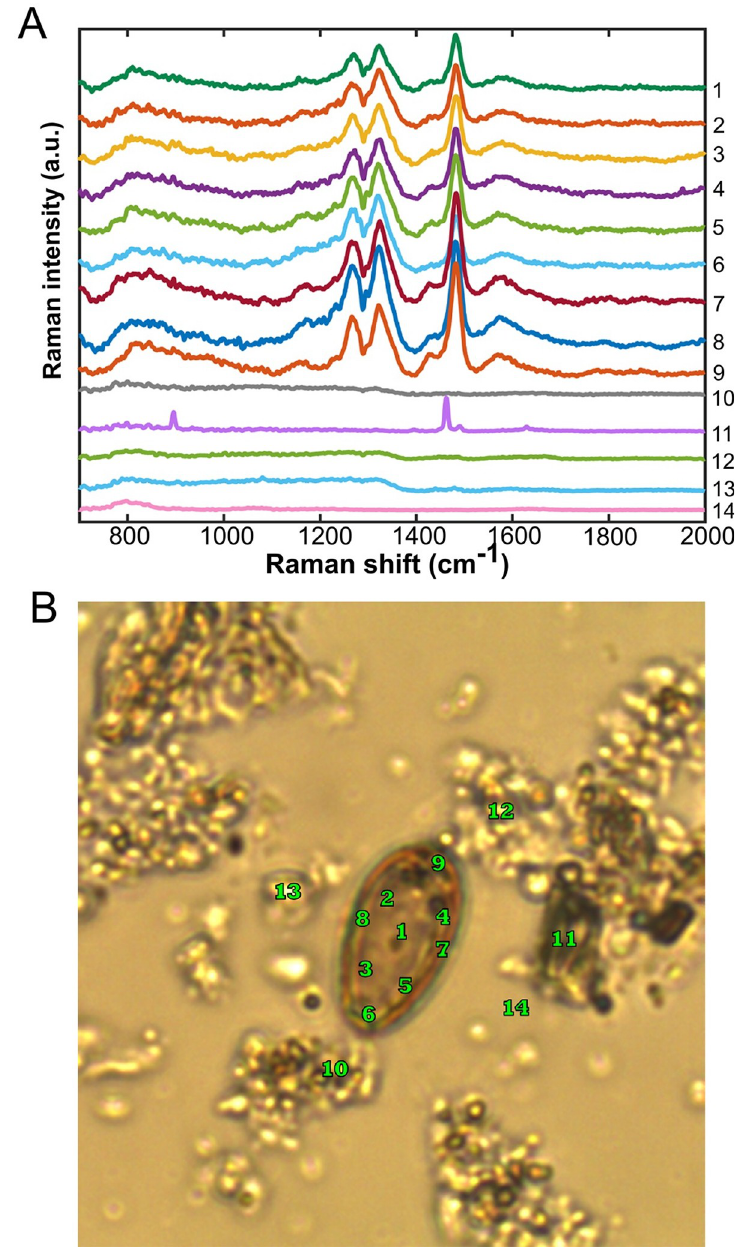
Fig 5. Lateral Raman scanning of an individual O . viverrini egg. (A) Raman spectra were taken at different spots, as shown in (B), within an O . viverrini egg vs. outside the egg boundary, i.e., within the region containing fecal debris. Spectra were offset for clarity of